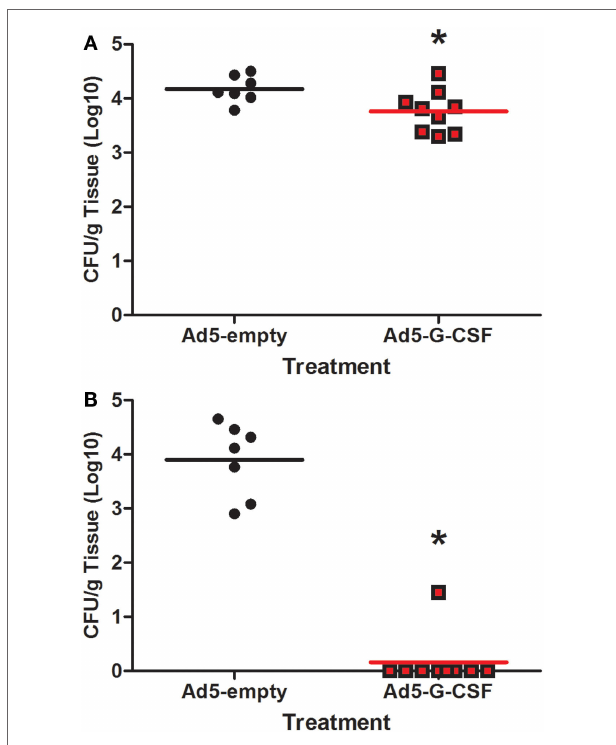
FigUre 3 | Tissue colonization from Salmonella -challenged pigs, with or without prior ad5-g-csF administration . At 7 d.p.i., Salmonella bacteriological analysis (CFU/g) of the (a) Peyer’s patch region of the ileum and (B) tonsils obtained during necropsy. *Significant difference ( P < 0.05) comparing Ad5-G-CSF-treated to Ad5-empty-treated pigs at the same time